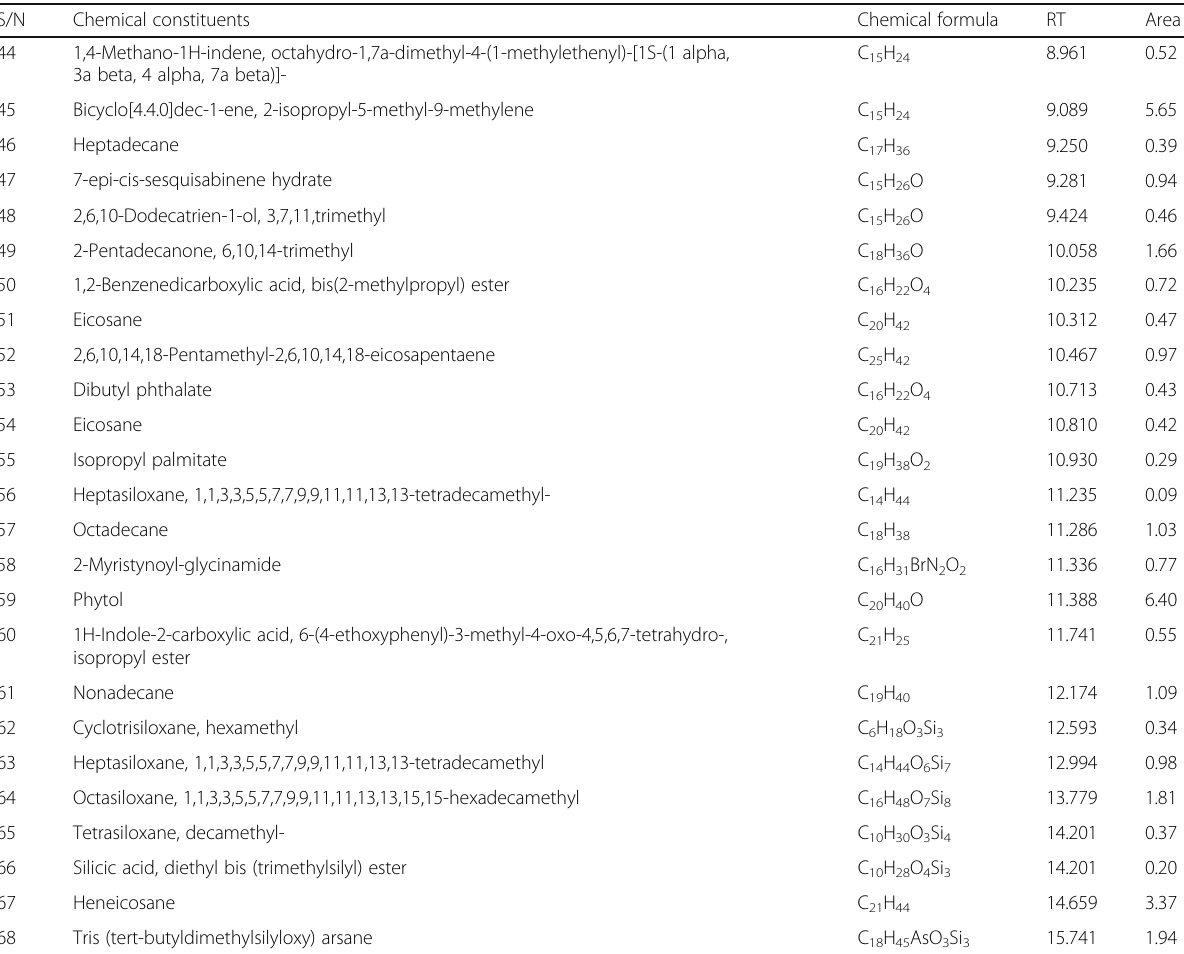
Table 3 Chemical composition of essential oils of Olea europaea (Continued) S/N Chemical